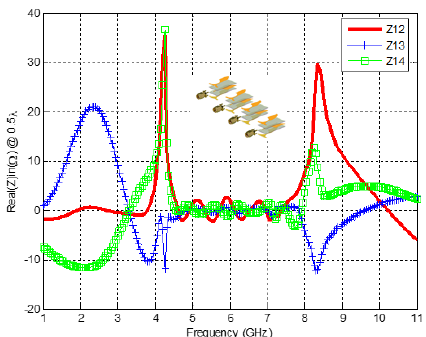
FIGURE 7. The receiving mutual impedance Z 12 of two Antipodal Vivaldi antenna